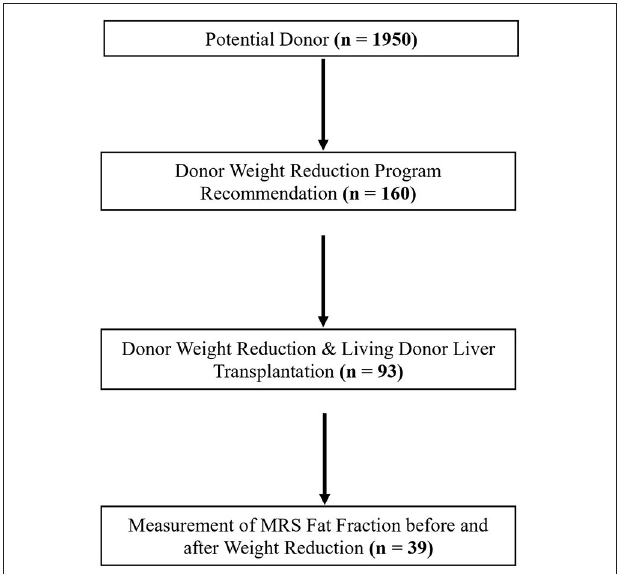
FIGURE 1 | Flow diagram of participant selection.